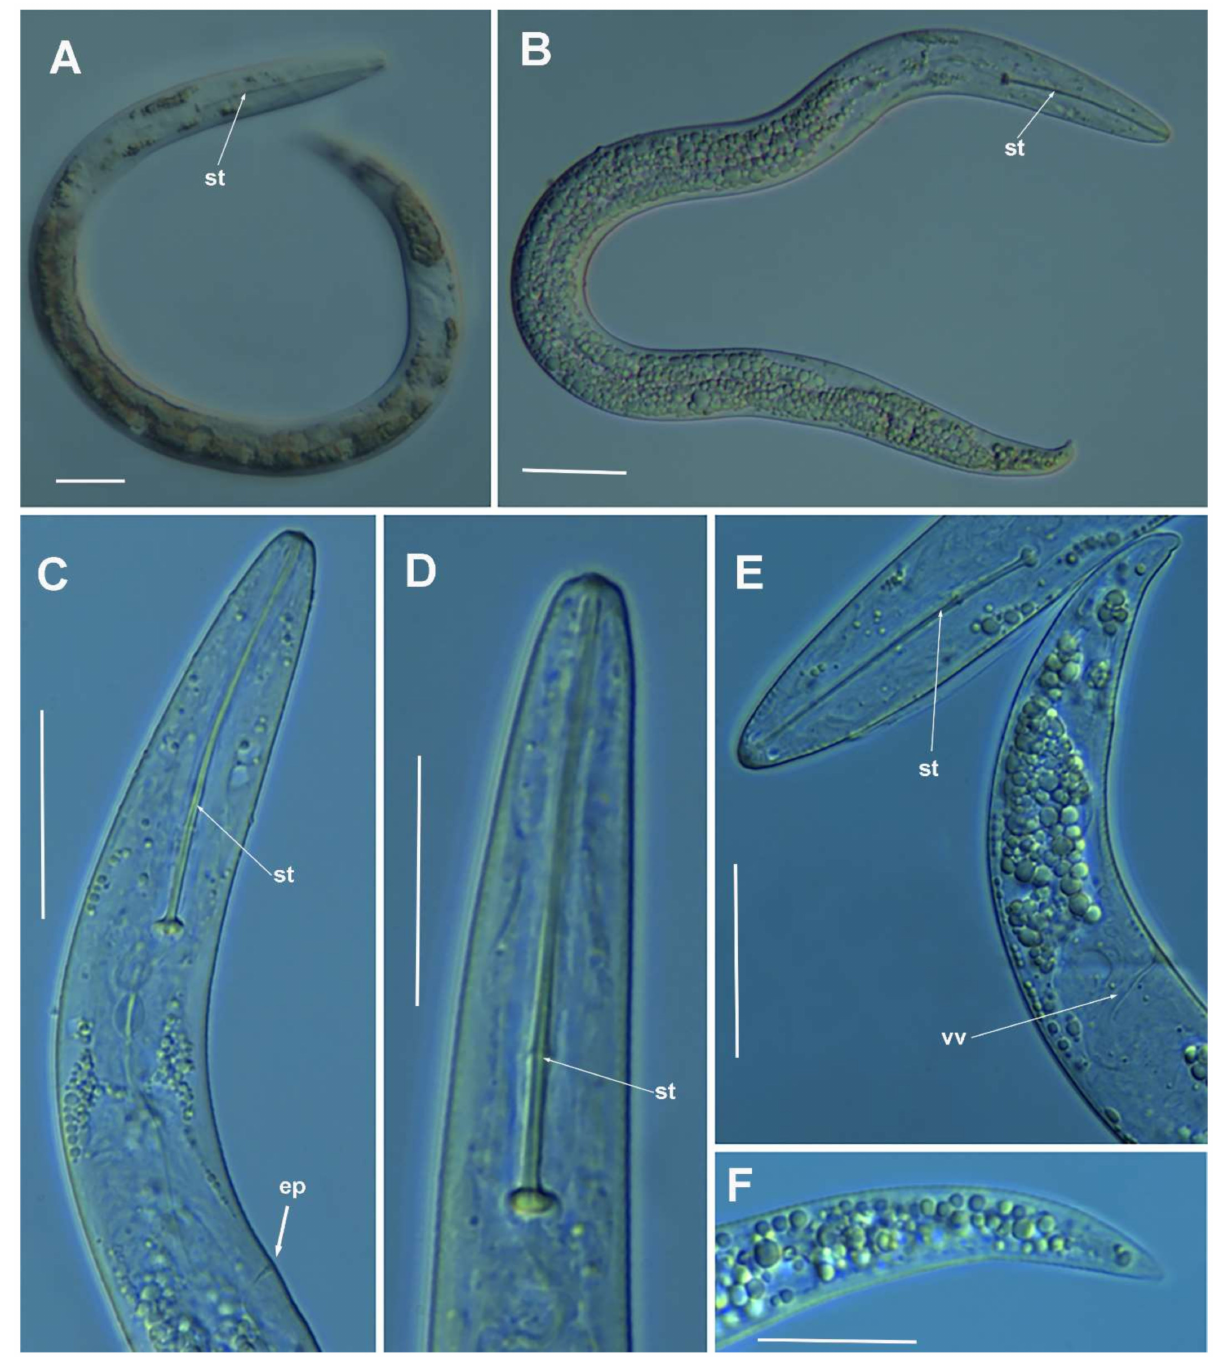
Figure 3. Light photomicrographs of Paratylenchus parastraeleni sp. nov. fourth-stage juveniles. ( A , B ) Entire fourth-stage juveniles showing stylet (arrowed); ( C , D ) fourth-stage juvenile pharyngeal region showing stylet; ( E ) fourth-stage juvenile anterior and posterior region showing stylet and initial vestigium of vagina (arrowed); ( F ) fourth-stage juvenile tail. Scale bars ( A – F = 20 µ m). (Abbreviations: ep = excretory pore; st = stylet; vv = vaginal